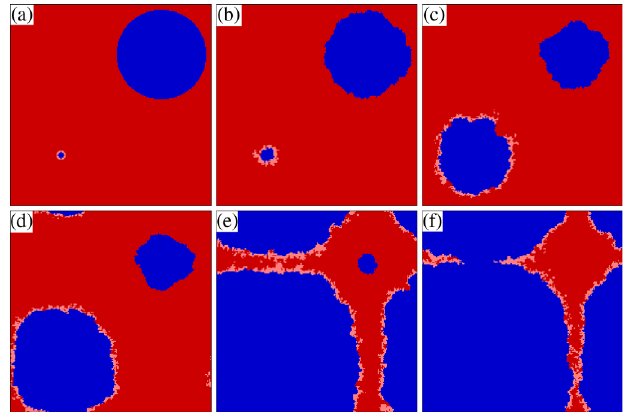
FIG. 5. An illustration of how second-order free-riding on antisocial punishment restores the effectiveness of prosocial punishment. A small domain of P players (dark blue), sur- C rounded by a thin layer of D players (light red), is inserted into the sea of P players (dark red) in the bottom left corner of the D lattice (a). Similarly, a sizable domain of P players, but without C the protective D layer, is inserted into the sea of P players in the D upper right-hand corner of the lattice (a). While the large P C domain without the protective layer shrinks over time, the small P domain with the protective D layer grows (b) – (f). The C absorbing P phase is reached after 2000 MCS (not shown). C The linear size of the square lattice in this case is L ¼ 200 . Other parameters are β ¼ 0 . 8 , γ ¼ 0 . 3 , and r ¼ 3 .